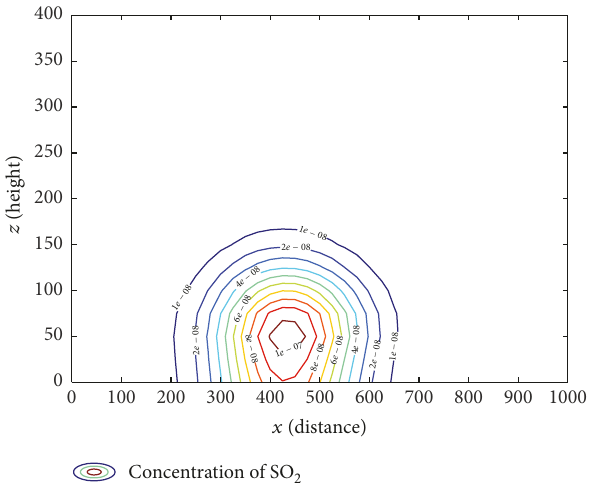
Figure 11: The concentration of air pollution with the different monitoring point at 𝑧 = 50 m by air quality standard ( 1.5 × 10 −7 kg/m 3 ).